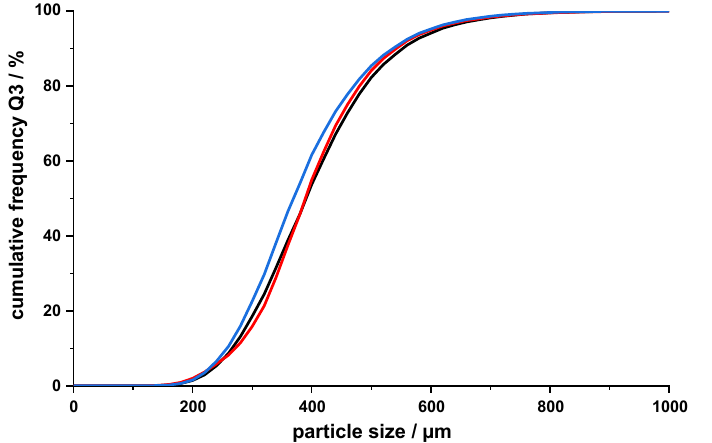
Figure 6. PSD of three MSMPR batches produced under identical conditions ( n = 1, entire batch).